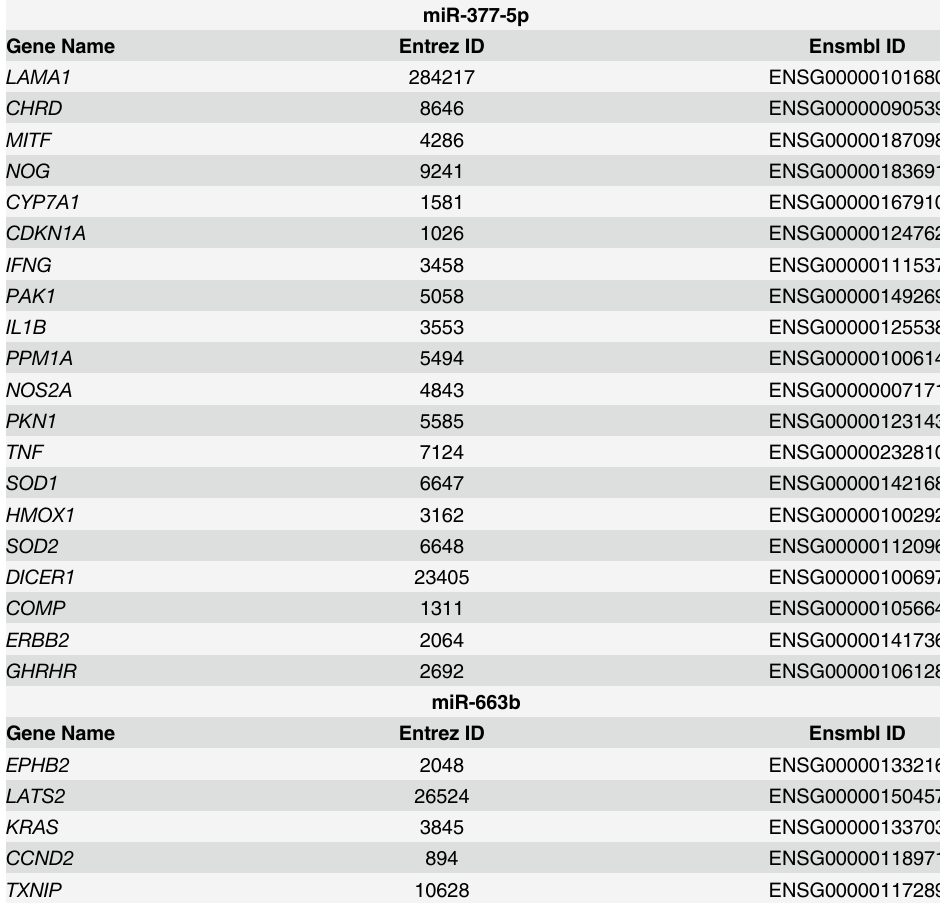
Table 3. Validated gene targets for miR-377-5p and miR-663b using